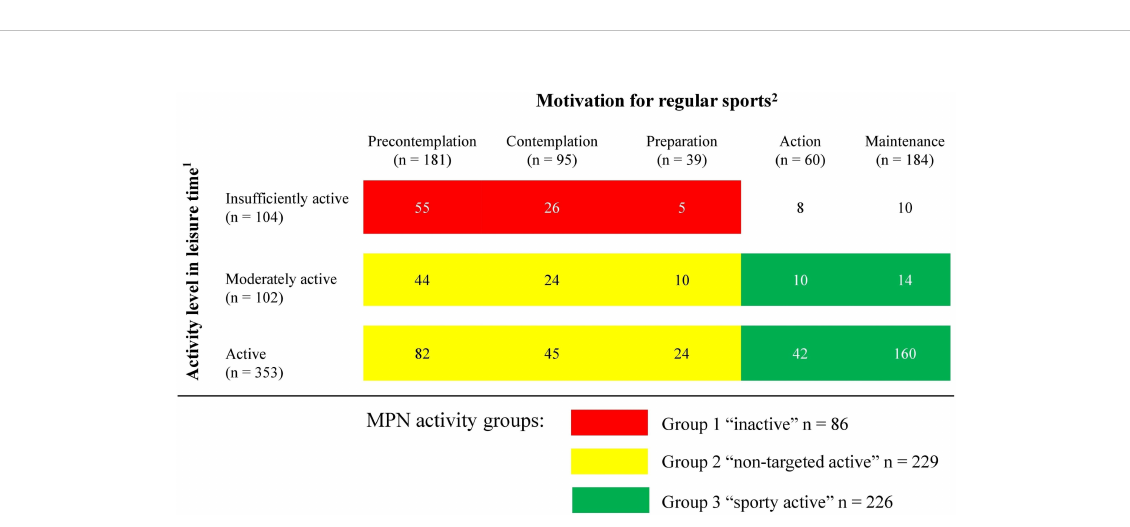
FIGURE 4 Physical activity in patients with myeloproliferative neoplasms (n = 559). Data are presented as the number of participants. 1 Activity levels in leisure time were grouped according to the Godin-Shepard Leisure-Time Physical Activity Questionnaire (GSLTPAQ) into three categories: “ insuf fi ciently active ” , “ moderately active ” , and “ active ” (15, 16). 2 Five stages of the transtheoretical model of behavioral change (SOC) were used to determine the motivation to participate in sports. In the stages of precontemplation, contemplation, or preparation, patients are not regularly active in sports. In the stages of action and maintenance, patients are active for at least 20 minutes on at least 3 days per week (17,